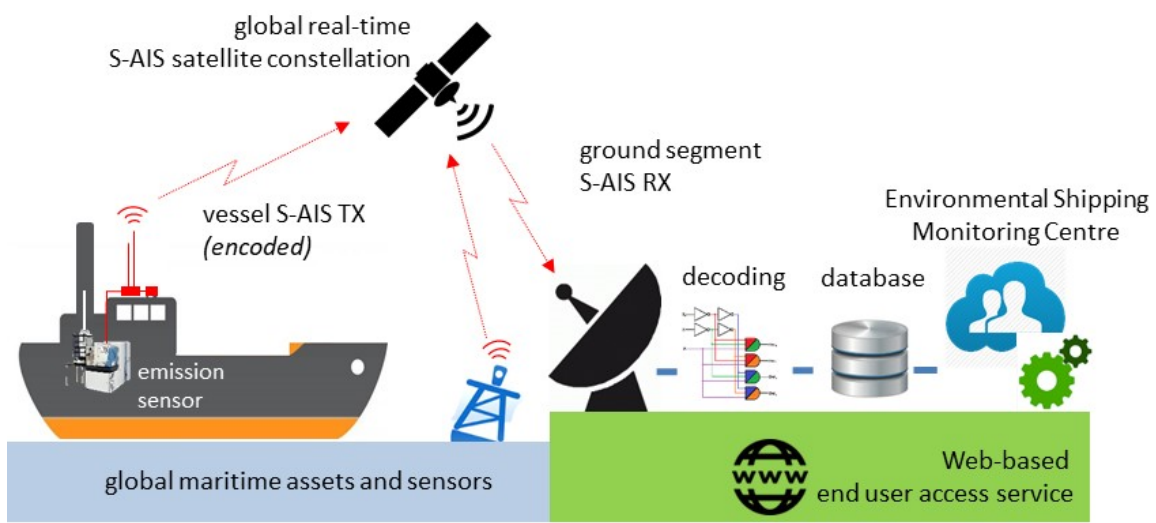
Figure 3. Schematic of the exactSeNS real-time satellite maritime VHF service showing the S-AIS encoding and decoding pipeline coupled to an end-user access service and visualisation.